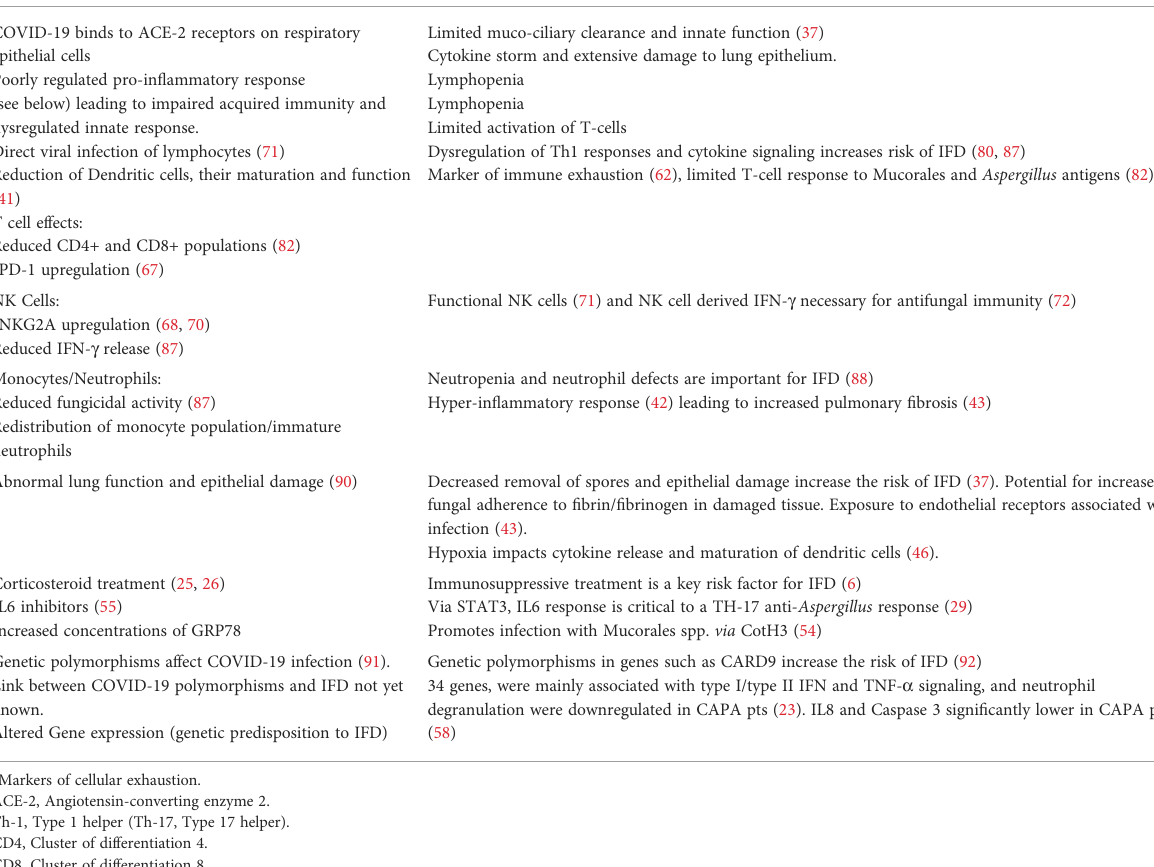
TABLE 1 Summary of the effects of SARS-CoV-2 infection on the host that match risk factors for the development of IFD. Effects of COVID-19 on